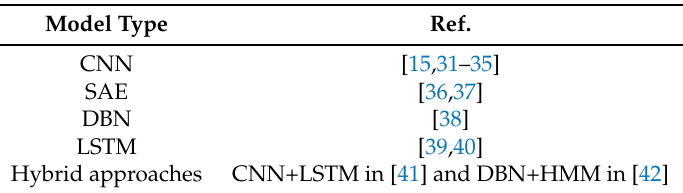
Table 1. Classification of related deep learning methods for smartphone-based human activity recognition (HAR). CNN: convolutional neural network; DBN: deep belief network; LSTM: long short-term memory network; SAE: stacked